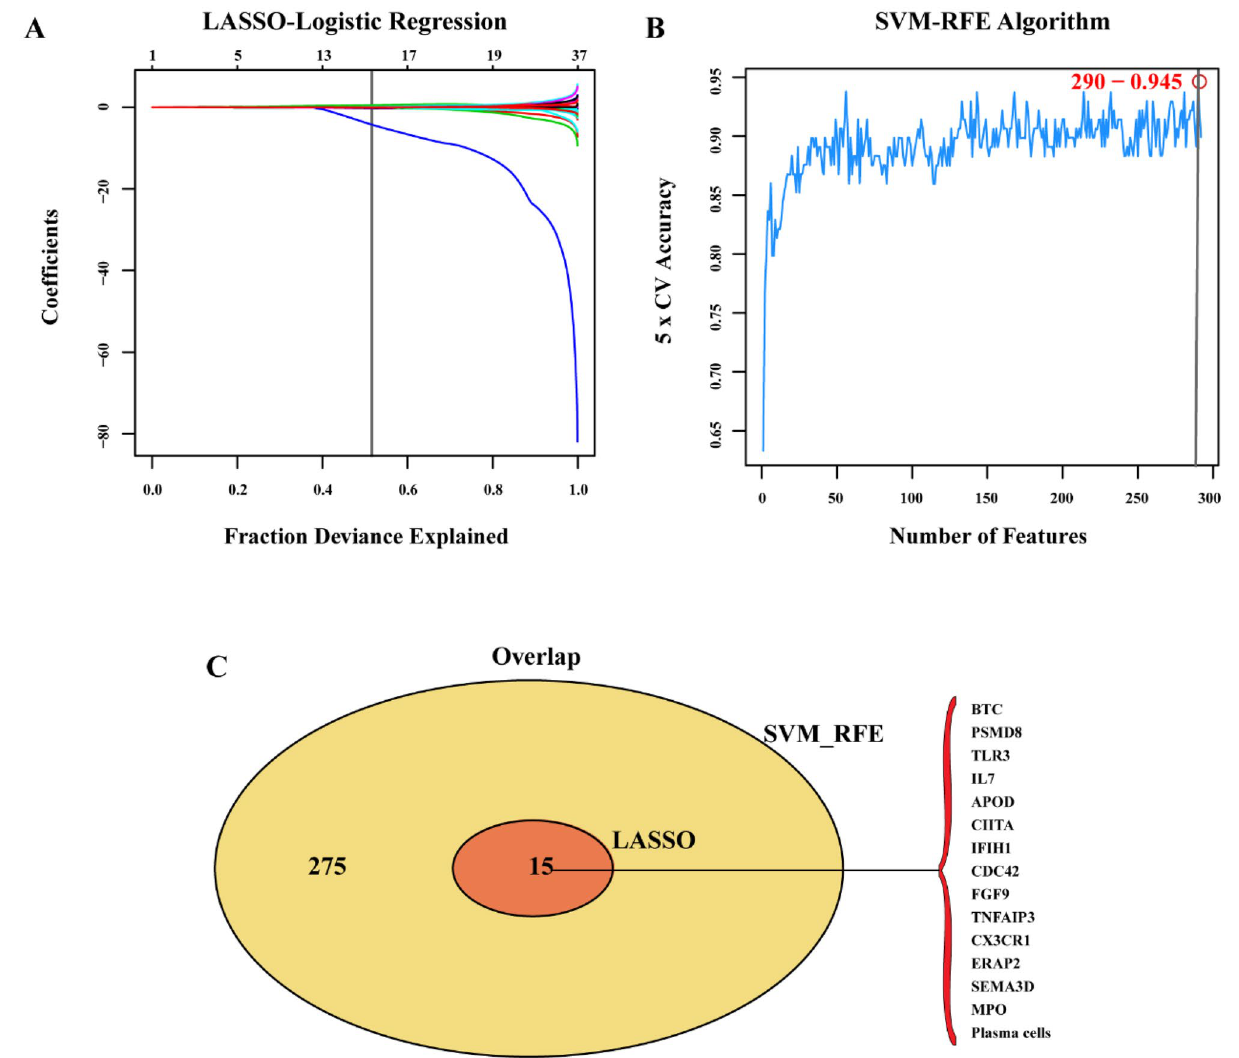
Figure 7. Biomarker selection was performed using two algorithms. ( A ) LASSO logistic regression algorithm to screen for biomarkers; ( B ) SVM-RFE algorithm for screening biomarkers; ( C ) Venn diagram showing the intersection of biomarkers obtained by the two